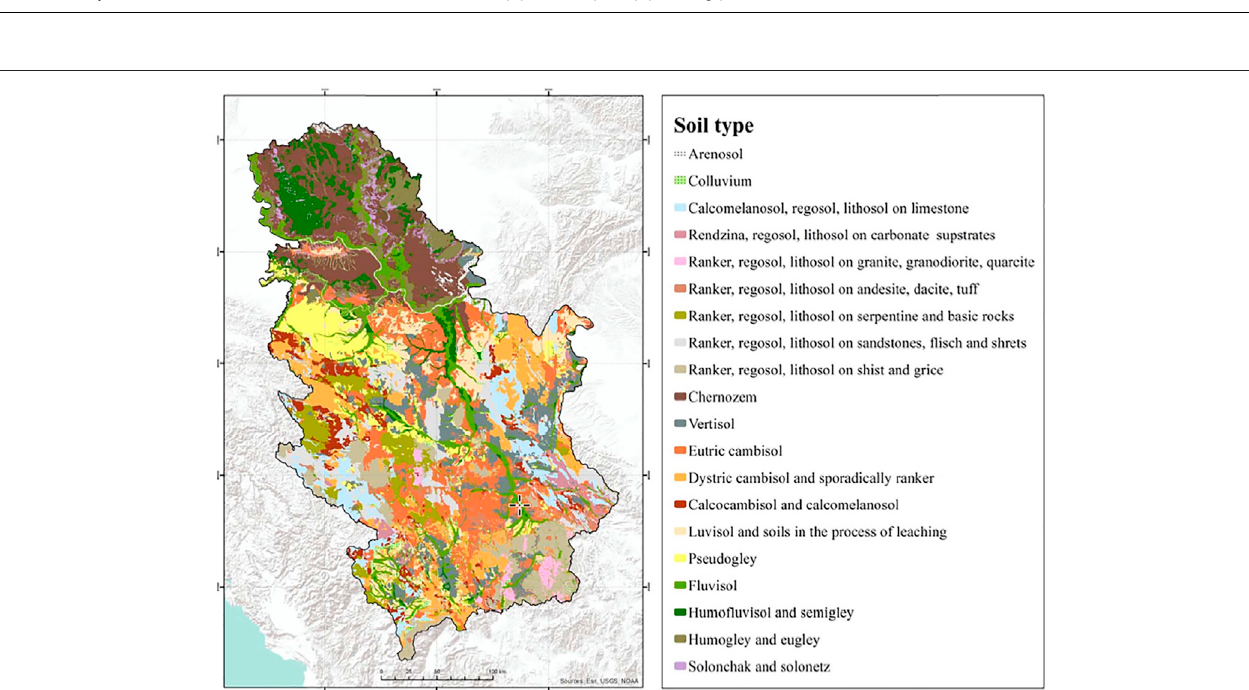
Frontiers in Chemistry |